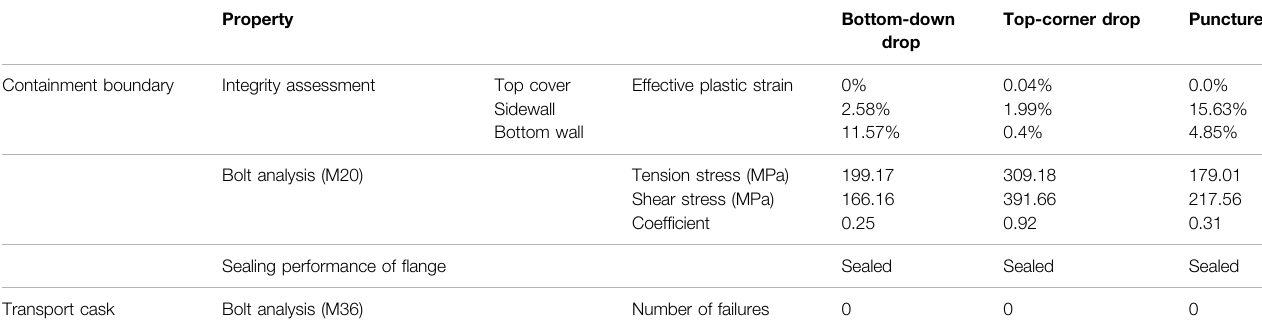
TABLE 2 | Automatic quick assessment output for three drop cases based on our